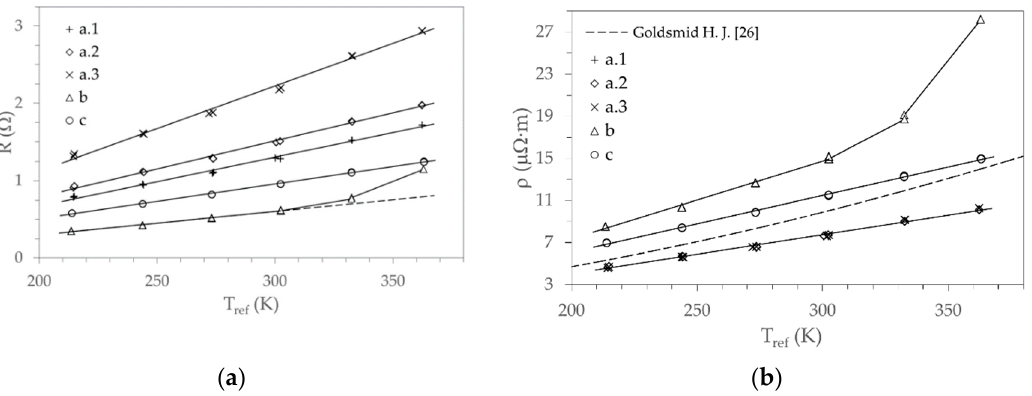
Figure 2. ( a ) Assembled p-n series resistance R given by Equation (1) versus the test reference temperature for each Peltier module; ( b ) Equivalent electrical resistivity of the assembled thermoelectric materials versus test reference temperature for each Peltier module. The dashed line represents a possible trend in temperature of the average electrical resistivity for the p and n doped Bi 2 Te 3 bulk materials, as found in the literature [26].